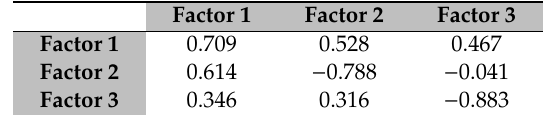
Table A3. Results of Varimax rotation (Varimax rotation matrix).